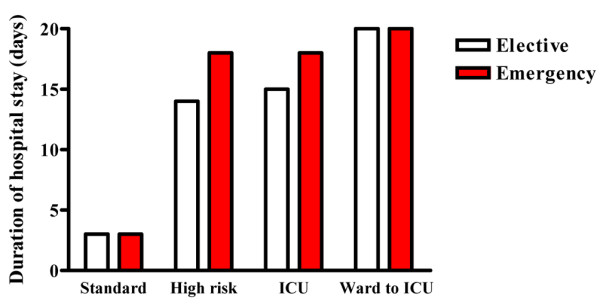
Duration of hospital stay for general surgical patients identified from the CHKS and ICNARC databases. CHKS database: standard, all patients admitted to hospital for a general surgical procedure with an overall mortality rate of less than 5%; high risk, subpopulation of patients undergoing a procedure with an overall mortality rate of 5% or more. ICNARC database: ICU, general surgical patients admitted directly to the intensive care unit following surgery; ward to ICU, patients admitted to the intensive care unit following initial postoperative care on a standard ward.